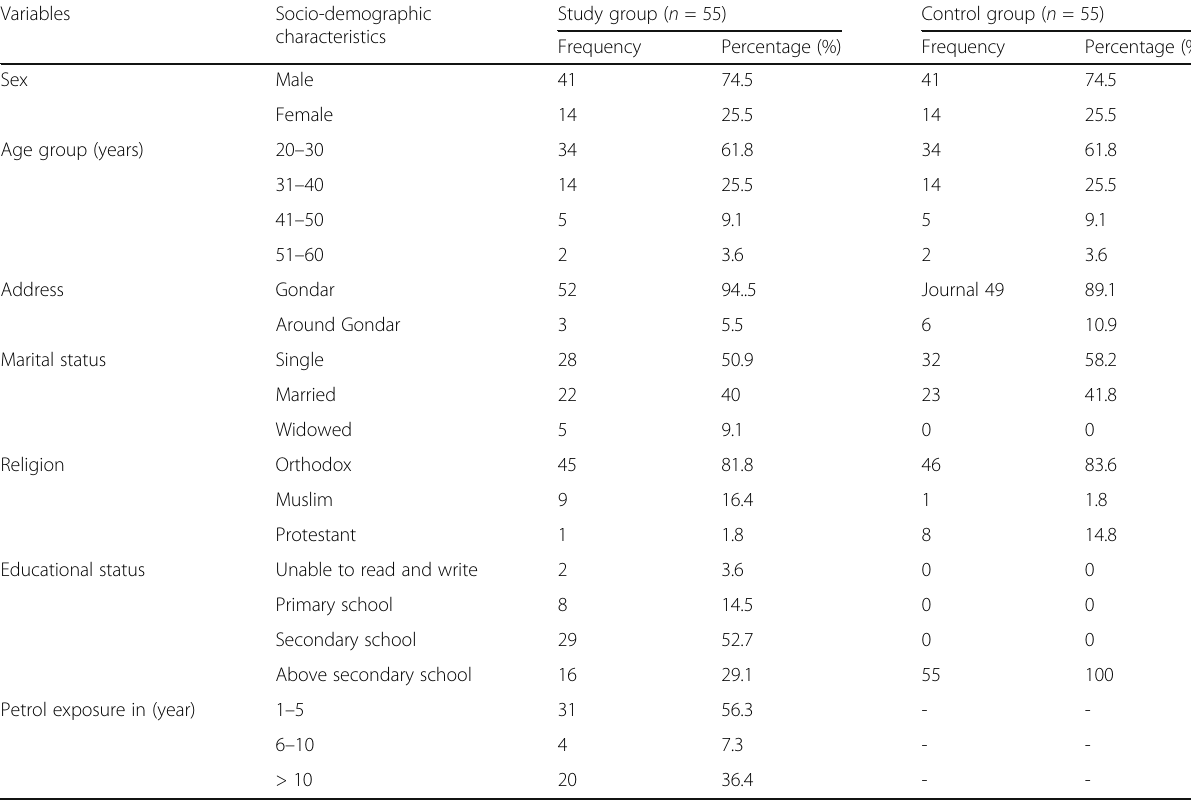
Table 1 Socio-demographic characteristics of study participants Variables Socio-demographic